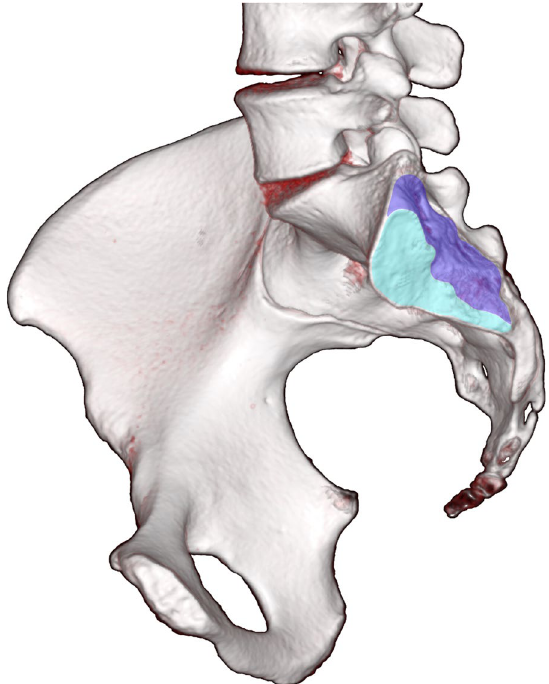
Fig. 1 Illustration of sacroiliac joint. In this illustration, the sacroiliac joint is divided into an anterior cartilaginous part (light blue) and a more posteriorly located ligamentous part (dark